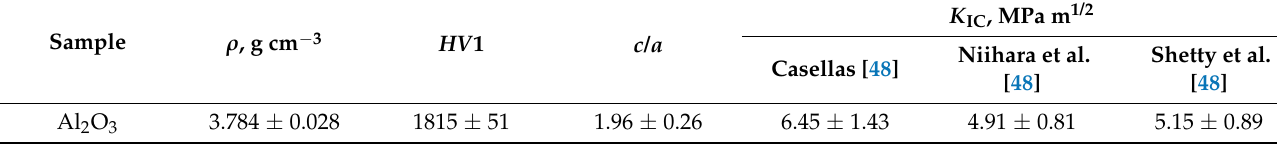
Table 4. Properties of sintered Al 2 O 3 samples: density, hardness ( HV 1), ratio of c/a, and Vickers indentation fracture toughness.